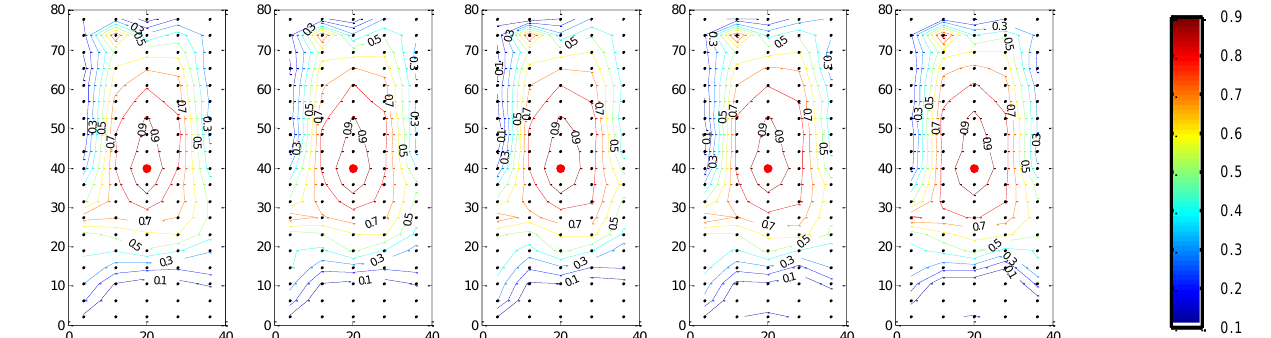
Figure 3. Lower rectangular model with higher curvature (RLC). Level curves of the correlation function between the pressure – time history in the center of the roof (pressure tap #48) and the other points of the roof surface, for different initial times t 0 . From left to right: t 0 = 0 s, t 0 = 4 s, t 0 = 8 s, t 0 = 12 s, t 0 = 16 s. The correlation between the pressure – time history at a given point of the roof and other points of the roof surface, on the other hand, quickly decays when the delay time τ between the two points is taken into account, as shown in Figure 4. This means that, not- withstanding the stationarity of the flow, the complex aerodynamics continuously and dynamically modifies the instantaneous local wind-induce pressure. This confirms the need to take into account the correlation between the pressure fields at different points, also if they are far from each other. The correlation may in fact have a large influence whenever global wind-induced loads are relevant for the design of the main structural elements.